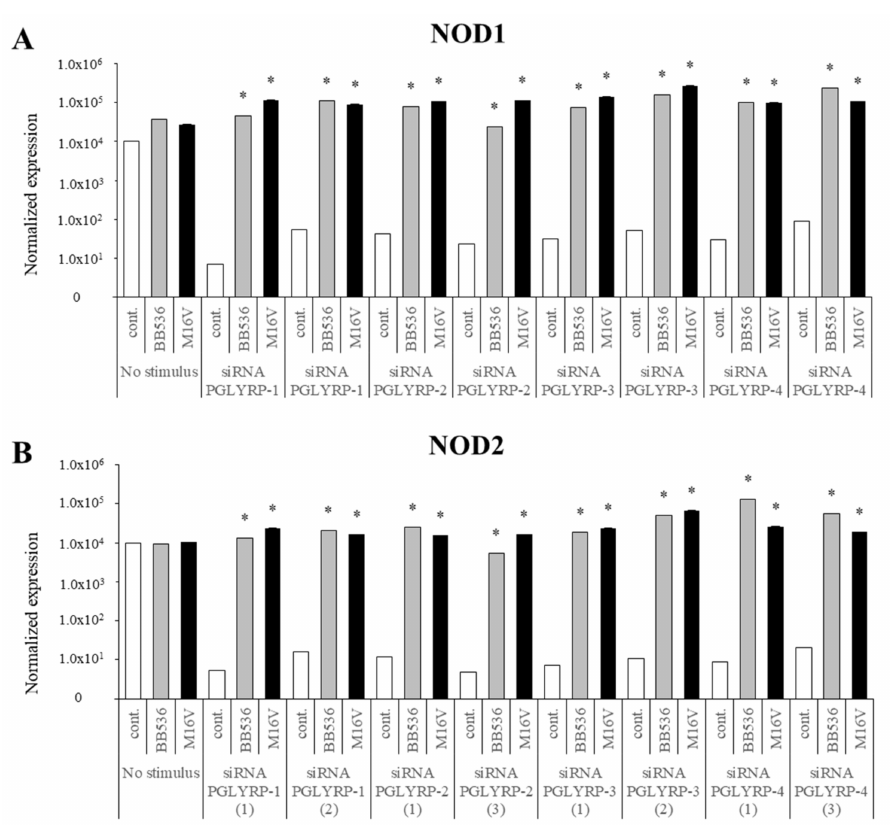
Figure 9. Paraimmunobiotic bifidobacteria-mediated expression of NOD1 and NOD2 in the peptidoglycan recognition proteins (PGLYRP)-knockdown porcine intestinal epithelial (PIE) cells. Porcine NOD1 ( A ) and NOD2 ( B ) expressions in PIE cells transfected with PGLYRP siRNAs and stimulated with Bifidobacterium longum subsp. longum BB536, or B. breve M-16V. Each mRNA level was normalized by the porcine β -actin mRNA and the normalized fold expression was determined in comparison to PIE cells with transfected negative control siRNA. The results are shown as means ± standard deviation obtained from three independent experiments ( n = 6). * p < 0.05 against